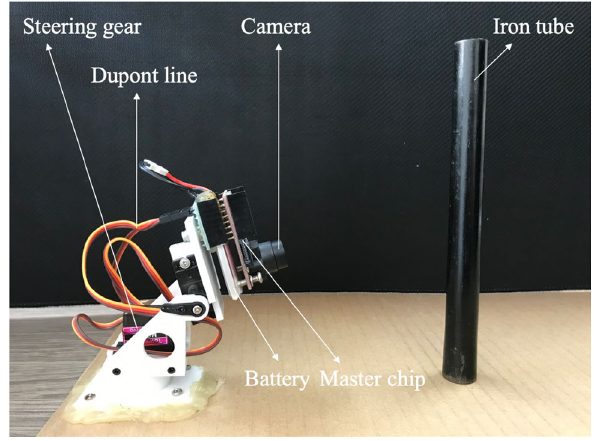
Fig. 8 Experimental device schematic Fig. 9 Schematic diagram of the iron